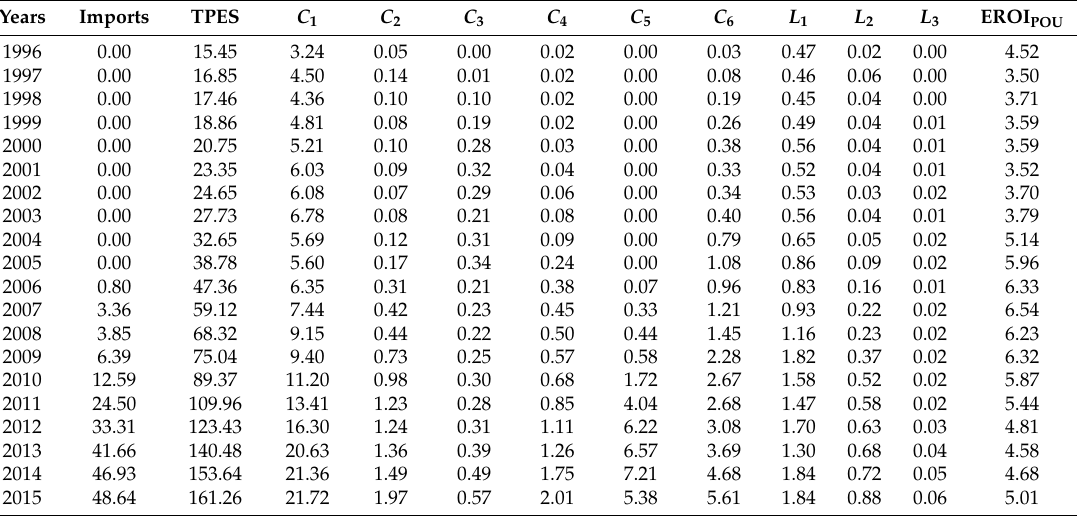
Table A3. Data for calculate EROI POU of natural gas in China (units: